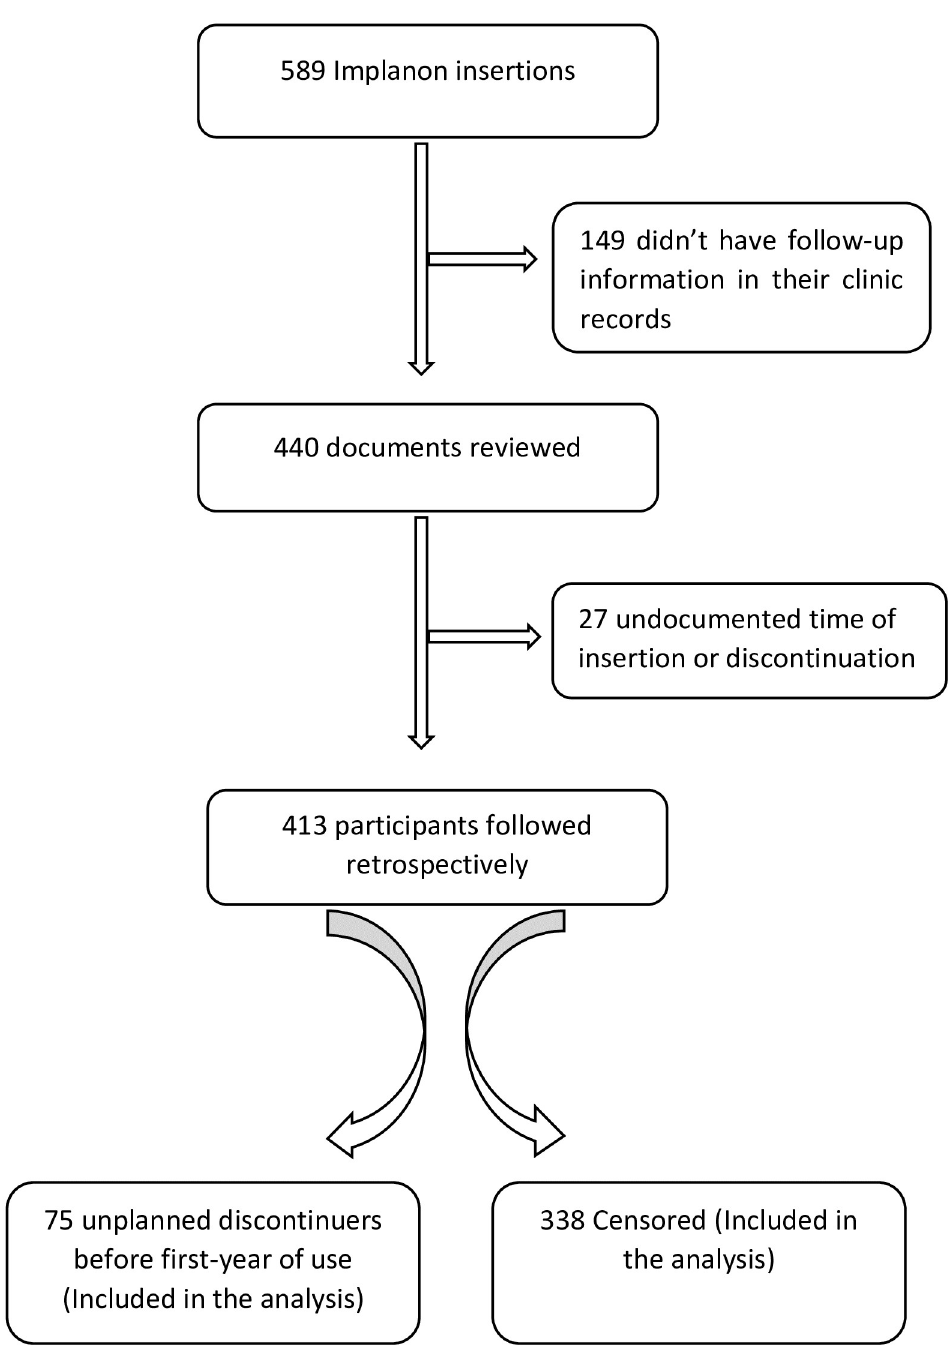
Fig 1. Flow of the study population illustrating the eligibility for inclusion in the analysis of unplanned discontinuation of Implanon at Ayder comprehensive specialized hospital, Mekelle, Northern Ethiopia, 2016–2017 (n =